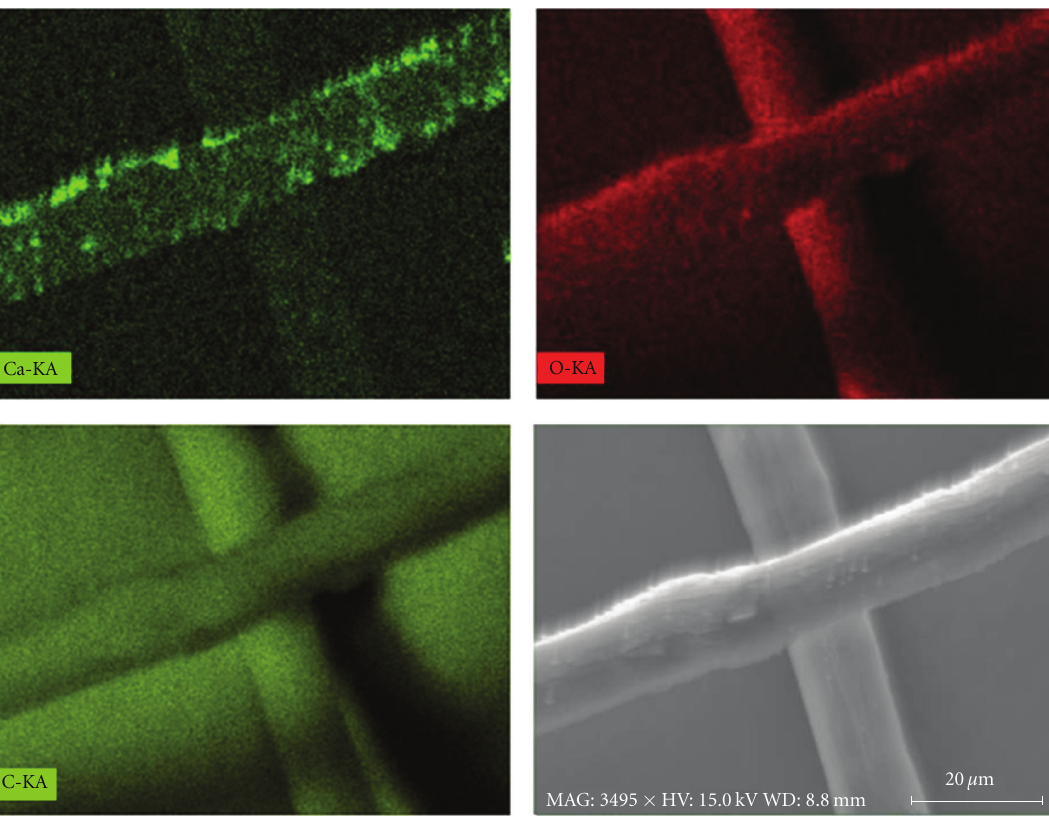
Figure 4: EDS elements mapping of kenaf fiber treated with INI process at 100 ◦ C (Na 2 CO 3 :CaCl 2 = 1 :2, mol:mol). Left top: calcium (Ca). Right top: oxygen (O). Left bottom: carbon (C). Right bottom: SEM image.